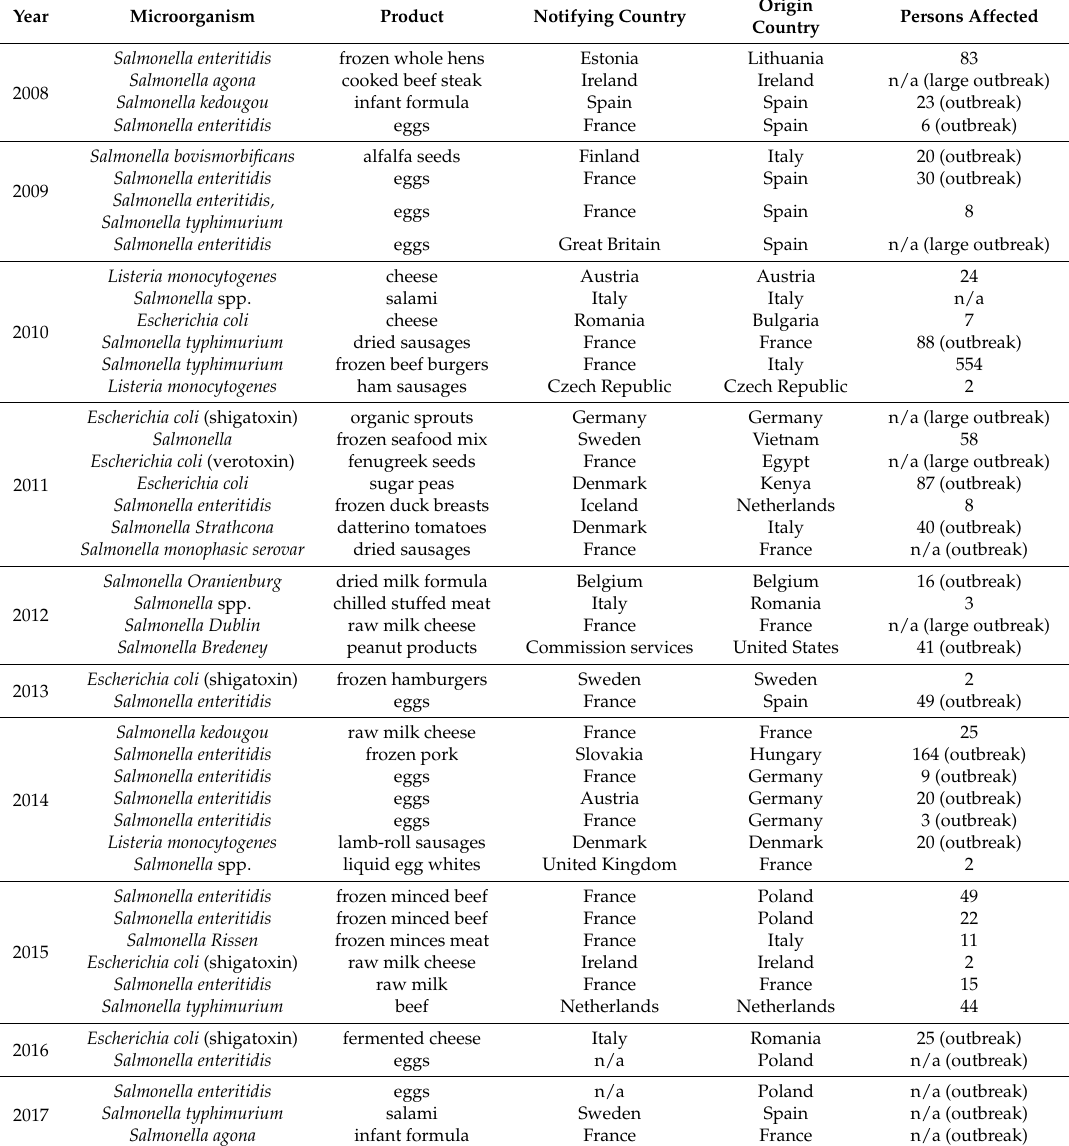
Table 1. Selected cases of food poisoning notified in the RASFF in